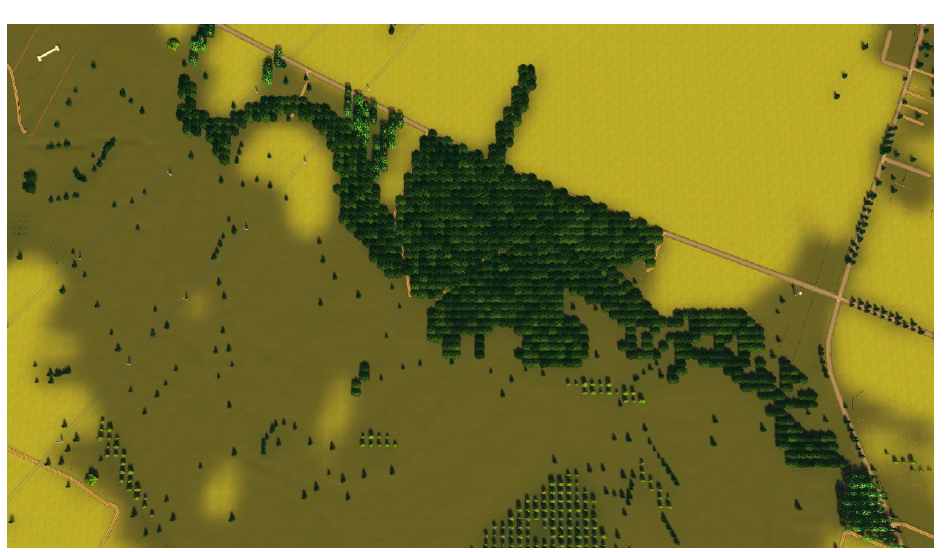
Figure 3. Results of covering a polygon with a forest.